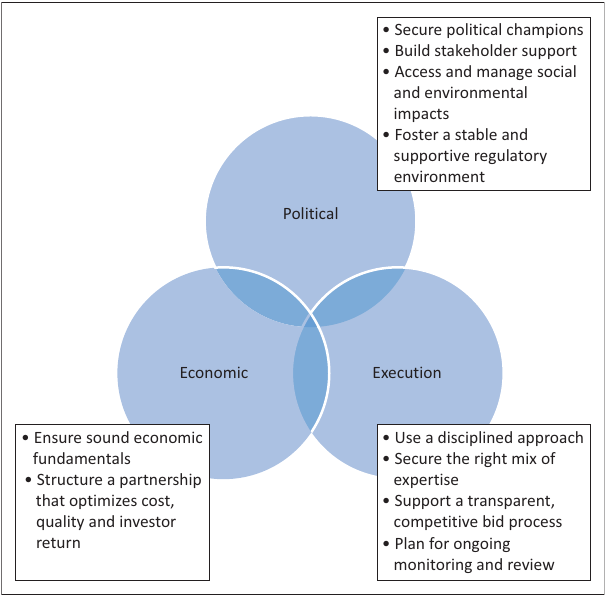
FIGURE 2: A framework for building successful public–private